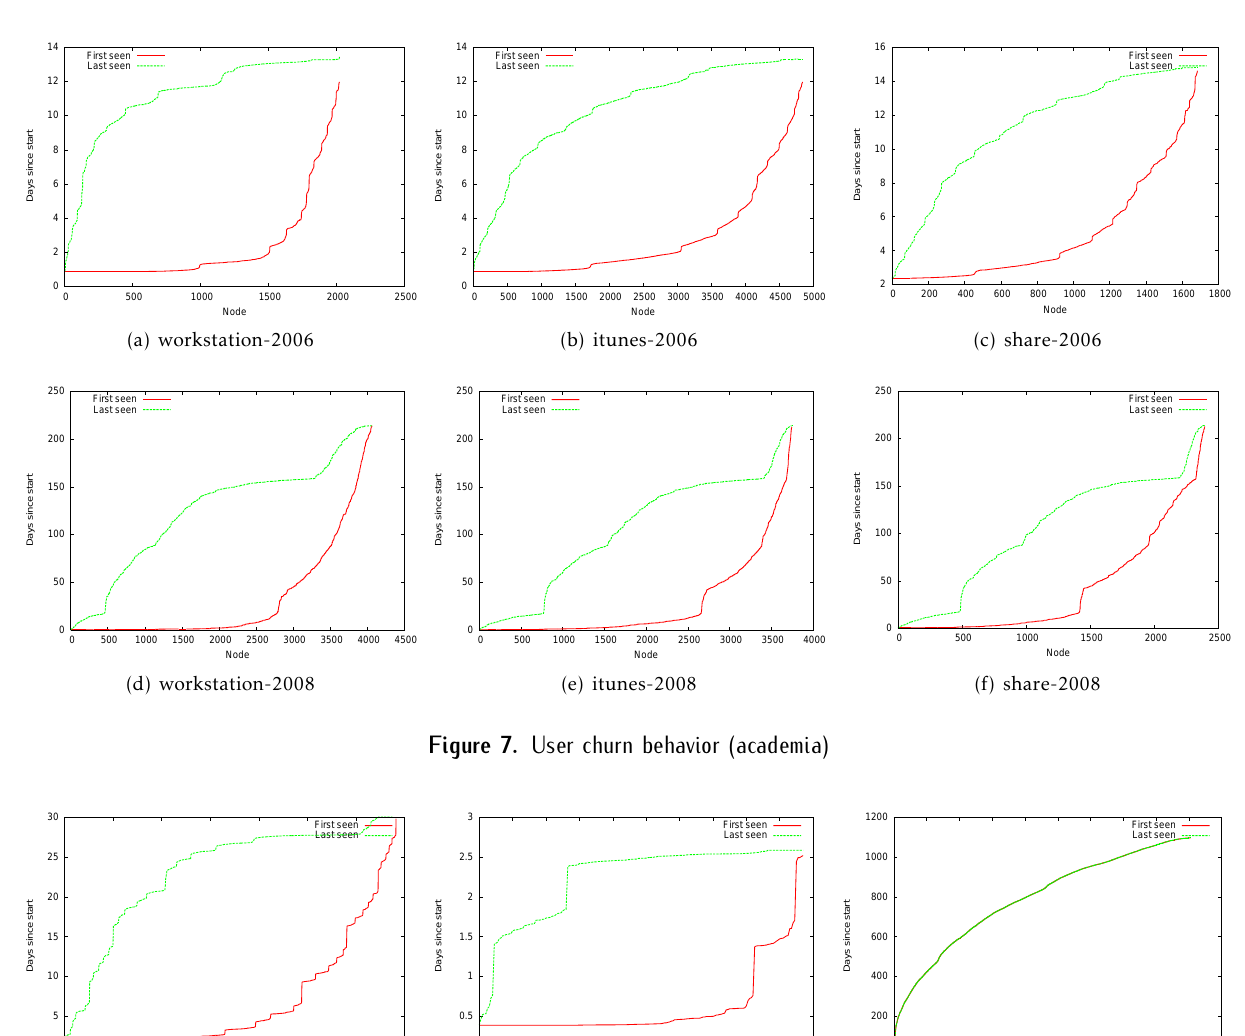
Figure 8. User churn